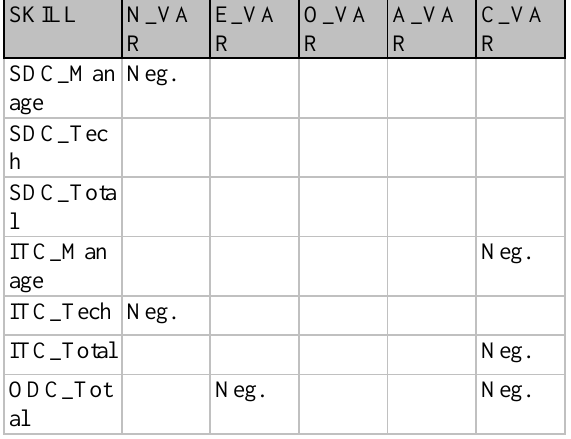
Table 6. Relationship between team variance personality and learning effectiveness (Neg.: negative correlation)